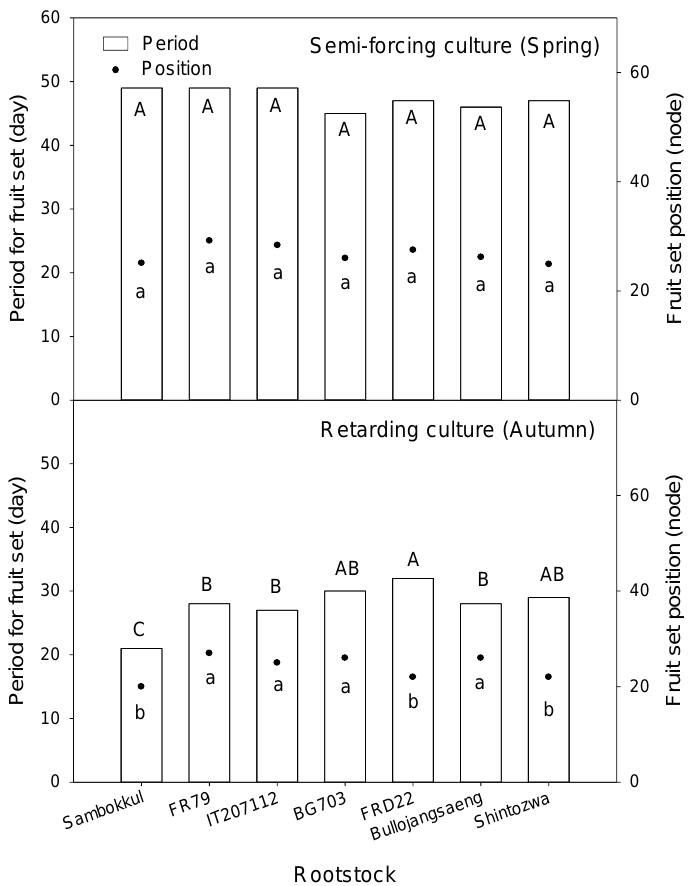
Figure 6. The fruit set position and period for fruit set after transplanting influenced by bottle gourd rootstocks. Different letters indicated a significant difference within the column at the p ≤ 0.05 according to Duncan’s multiple range test.